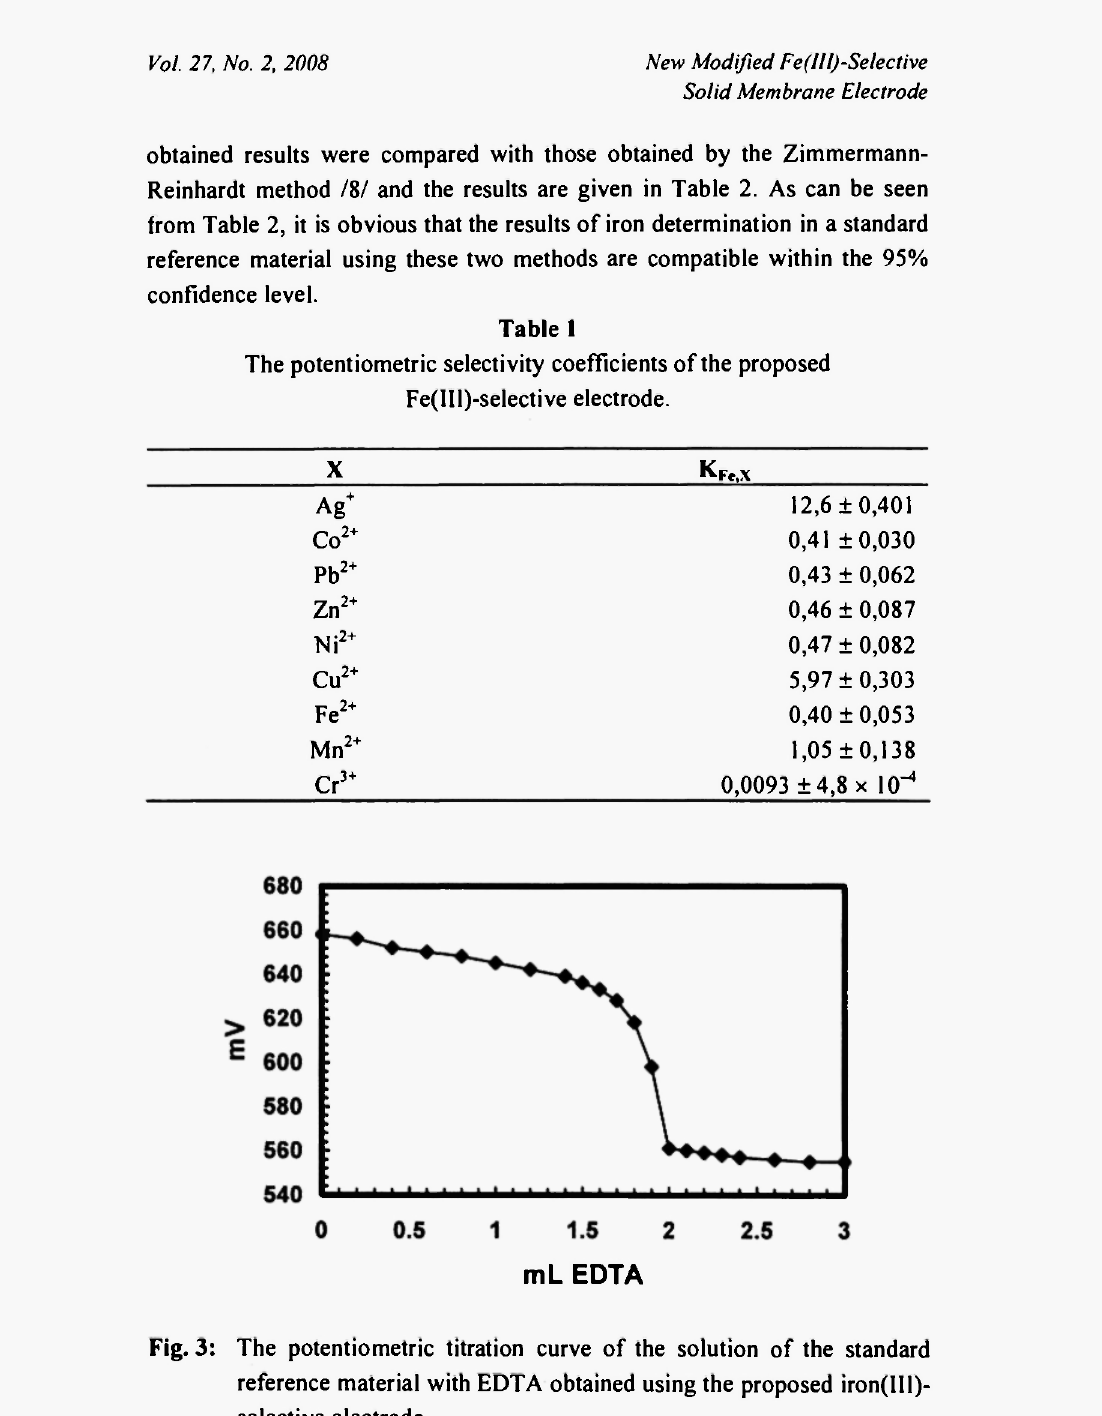
Fig. 3: The Potentiometrie titration curve of the solution of the standard reference material with EDTA obtained using the proposed iron(IIl)- selective